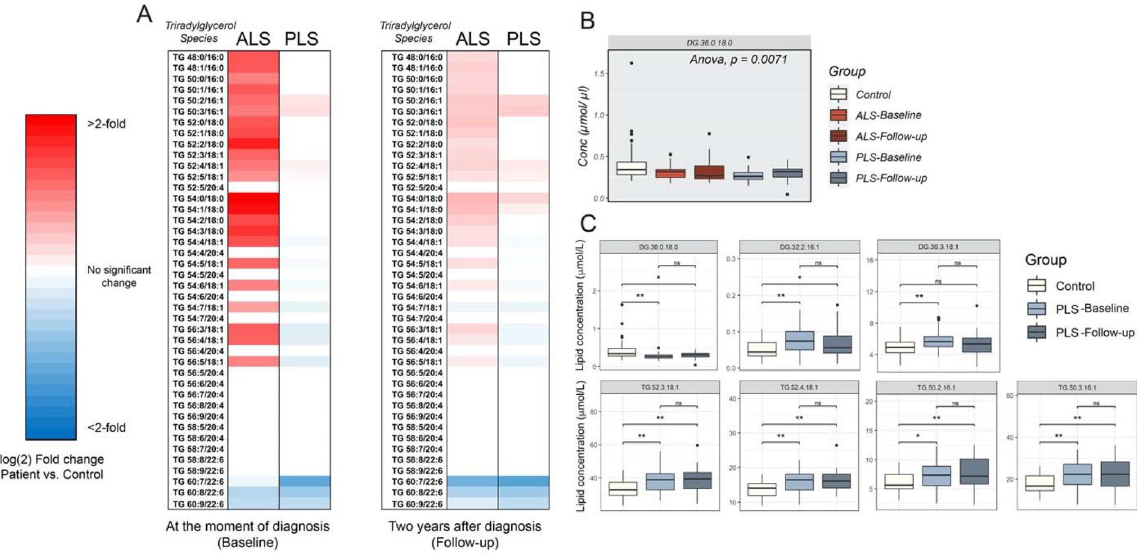
Figure 5. Analysis of TG in plasma from ALS and PLS patients compared to controls ( A ) Heat map representation of the most significant fold-changes in the concentration of Triradylglycerols (TG) species in plasma from ALS and PLS patients compared to controls at the beginning of the study (baseline) and 2 years after (Follow-up) (n = 40 ALS , n = 26 PLS samples and 28 controls analyzed in triplicate. *< 0.05; **< 0.01. T-Test). ( B ) Graph representation of DG species average concentration in ALS and PLS plasma compared to controls. One-way ANOVA. P values are indicated ( C ) Box plot representations of the most significant fold- changes in the concentration of di- and triglyceride species in plasma from PLS patients compared to controls at the beginning of the study (baseline) and 2 years after (Follow-up) (n = 26 PLS samples and 28 controls analyzed in triplicate. *< 0.05; **< 0.01.